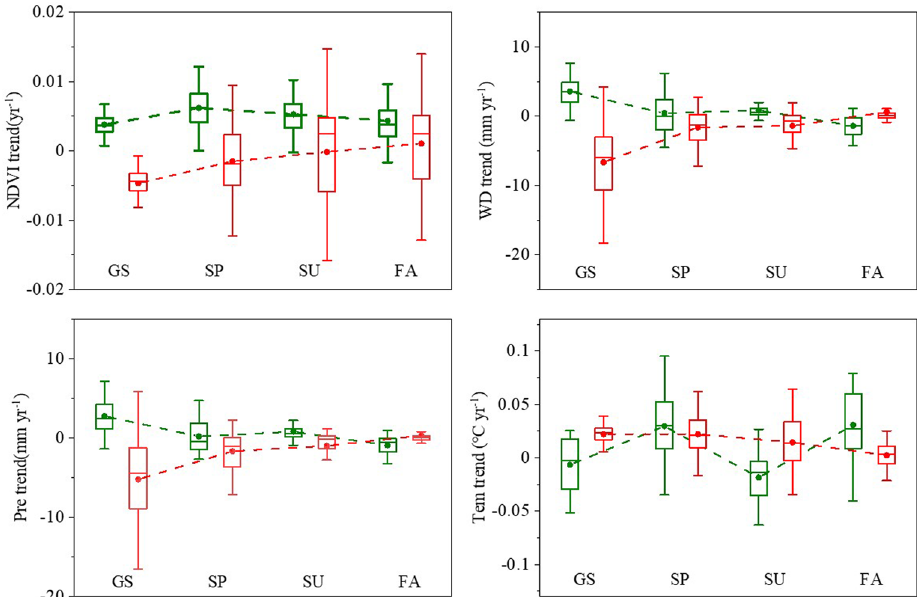
Figure 7. NDVI, temperature, precipitation and water deficit trend box chart of HMA for growth season, spring, summer and fall from 1982 to 2015. Green represents 1982 to 1998 and red represents 1998 to 2015. The box plot is drawn by the trend values of grid points passing the significance test (P < 0.001) (Generated by Origin 2020b, URL: https:// www. origi nlab.